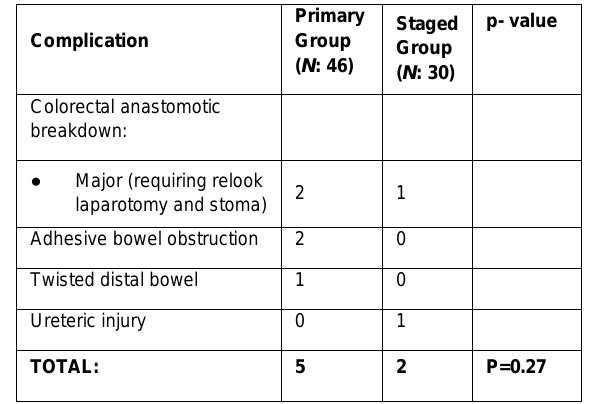
Table 3: Major Perioperative complications